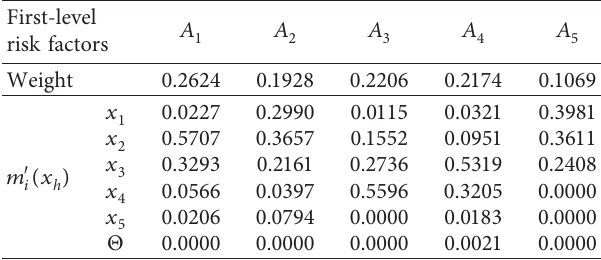
Table 8: Fusion basic belief degree of risk factors. Table 9: Risk level probability of overall risk.